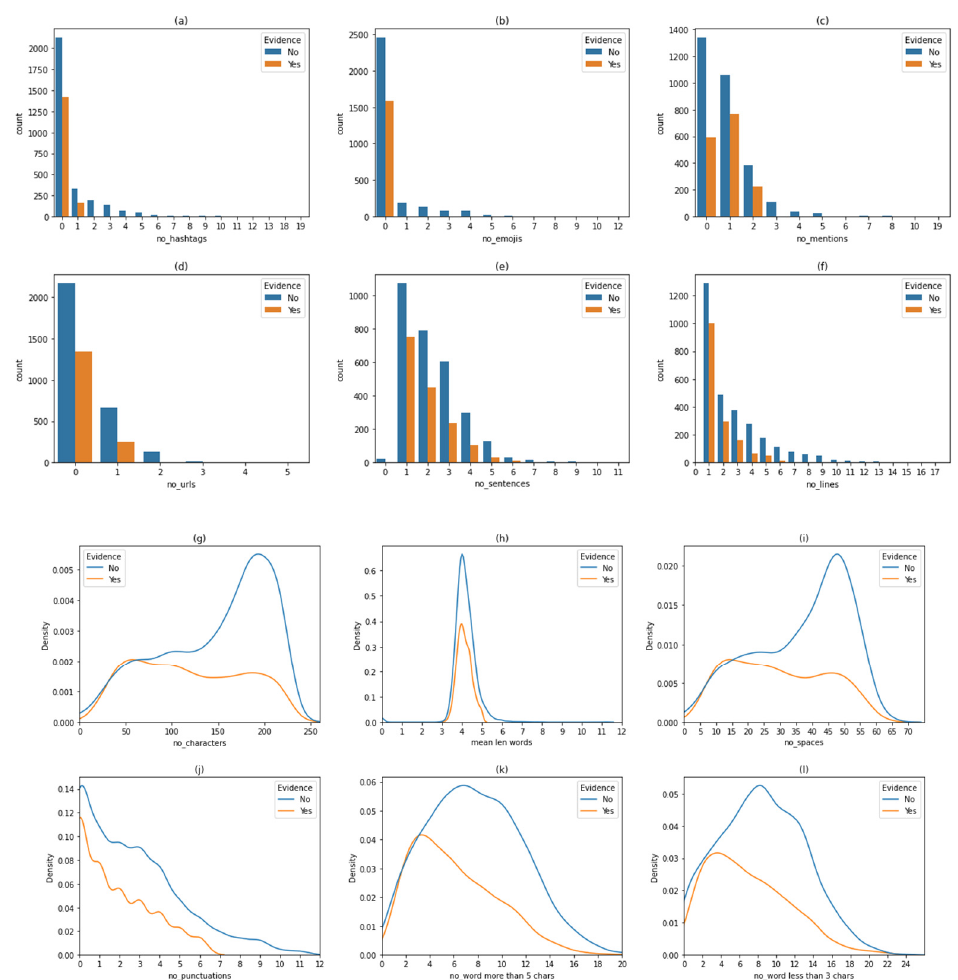
Figure 5. Comparative charts related to the features .